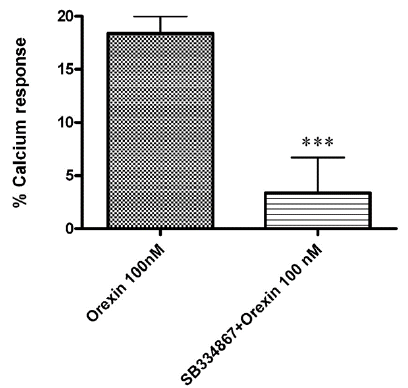
Figure 2. Effect of CBD on Ca 2+ elevation induced by 100 nM OX-A in CHO cells overexpressing OX1R. Data (mean ± SEM of five independent experiments) are expressed as a percent of the maximal effect observed with OX-A alone (see Figure 3); vertical lines show SEM.